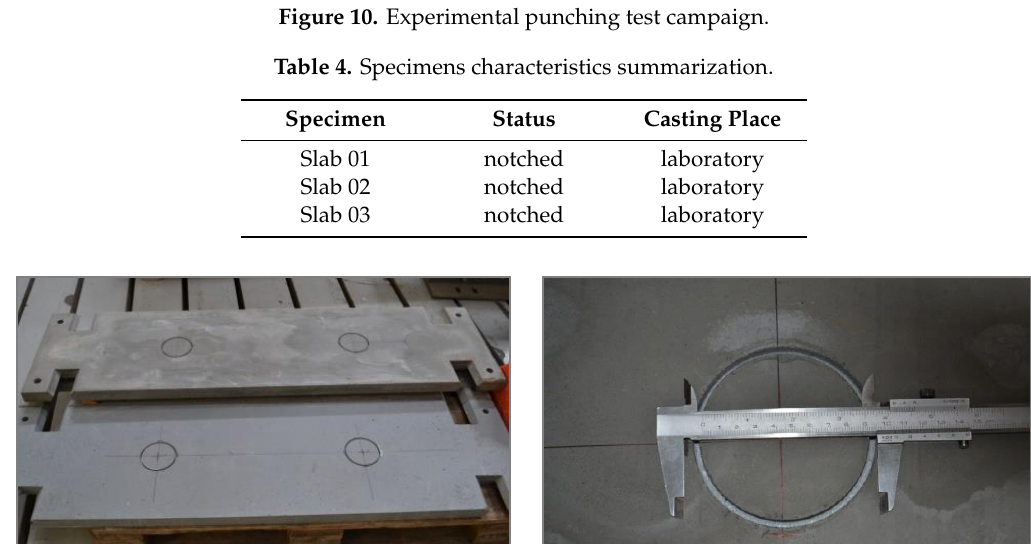
Figure 11. Notched slabs (on the left) and detail of the notch (on the right).